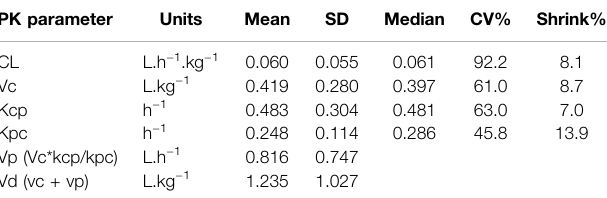
TABLE 6| Populationpharmacokineticmodeldataofvancomycinconcentrations of paediatric patients undergoing extracorporeal membrane